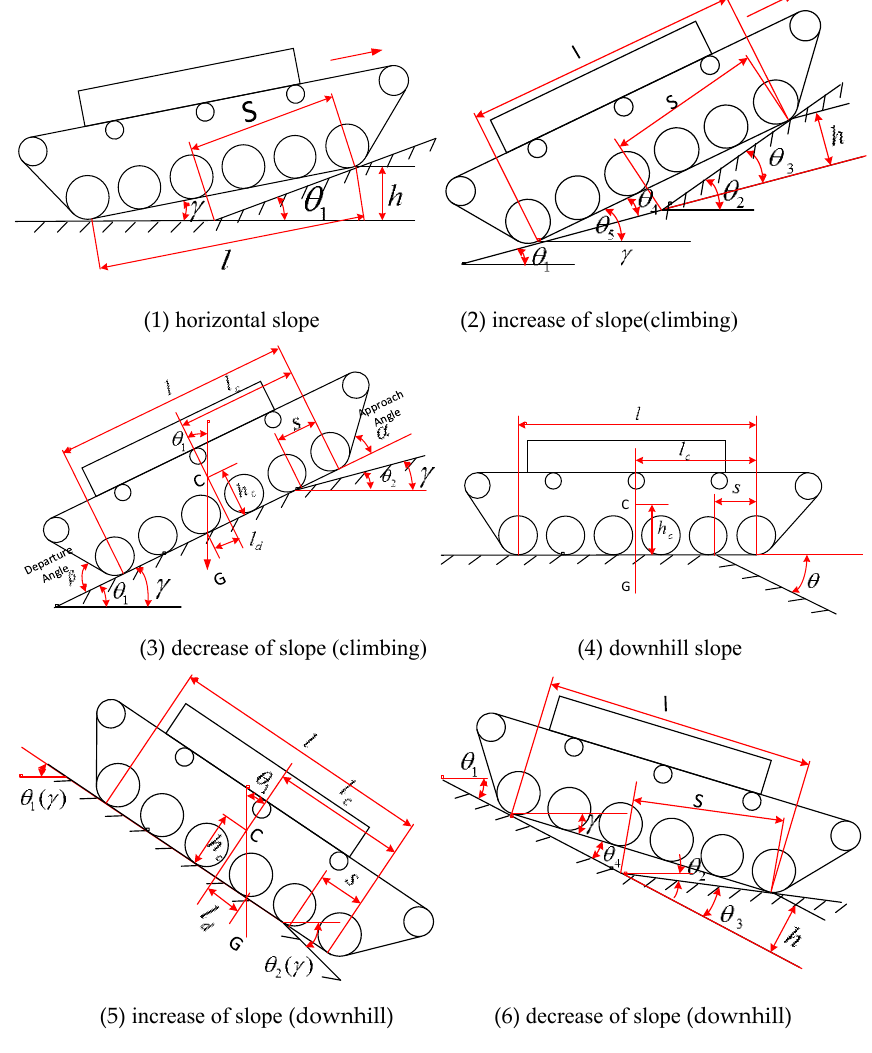
Figure 3. Force analysis of a tracked vehicle.